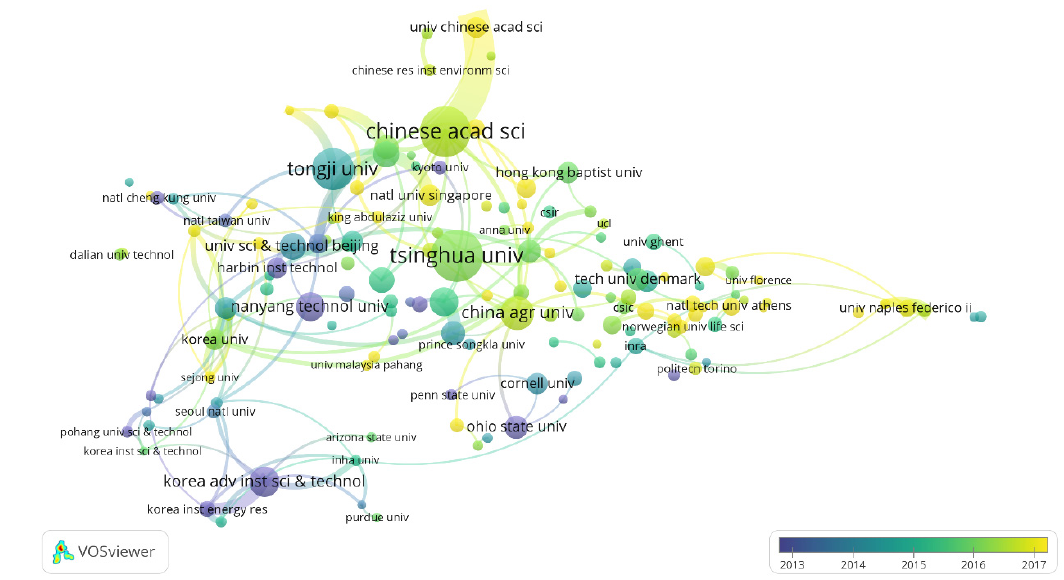
Figure 4. Mapping knowledge domains of coauthoring organization in FW studies.